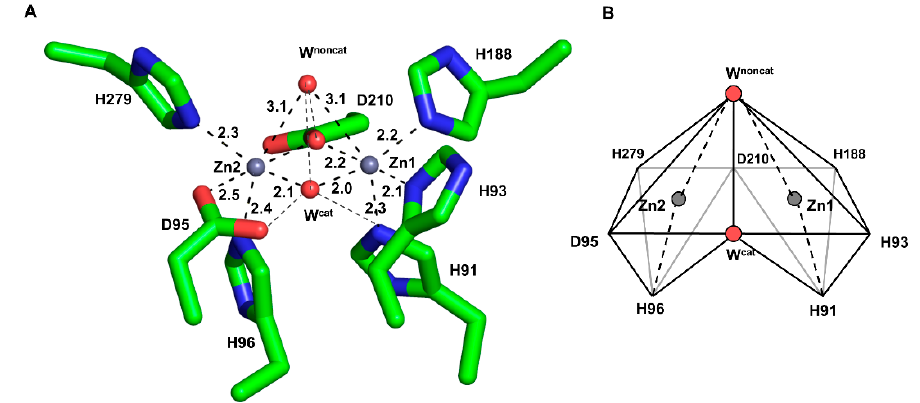
Figure 1. The metal-binding site (MBS) of wild-type PNGM-1. ( A ) The MBSs of Zn1 (right) and Zn2 (left) are displayed. A zinc ion (grey sphere) is bound to each MBS and coordinates to six coordination partners (shown in stick mode) with coordination distances of 2.0–3.1 Å. Water molecules are displayed as red spheres. The catalytic and non-catalytic water molecules are labeled as W cat and W noncat , respectively. Coordinations are indicated by dashed lines. ( B ) Scheme of the metal-binding geometry. The coordination partners and metal ion in each MBS exhibit an octahedron geometry. The binding site consists of two combined zinc-centered octahedrons.